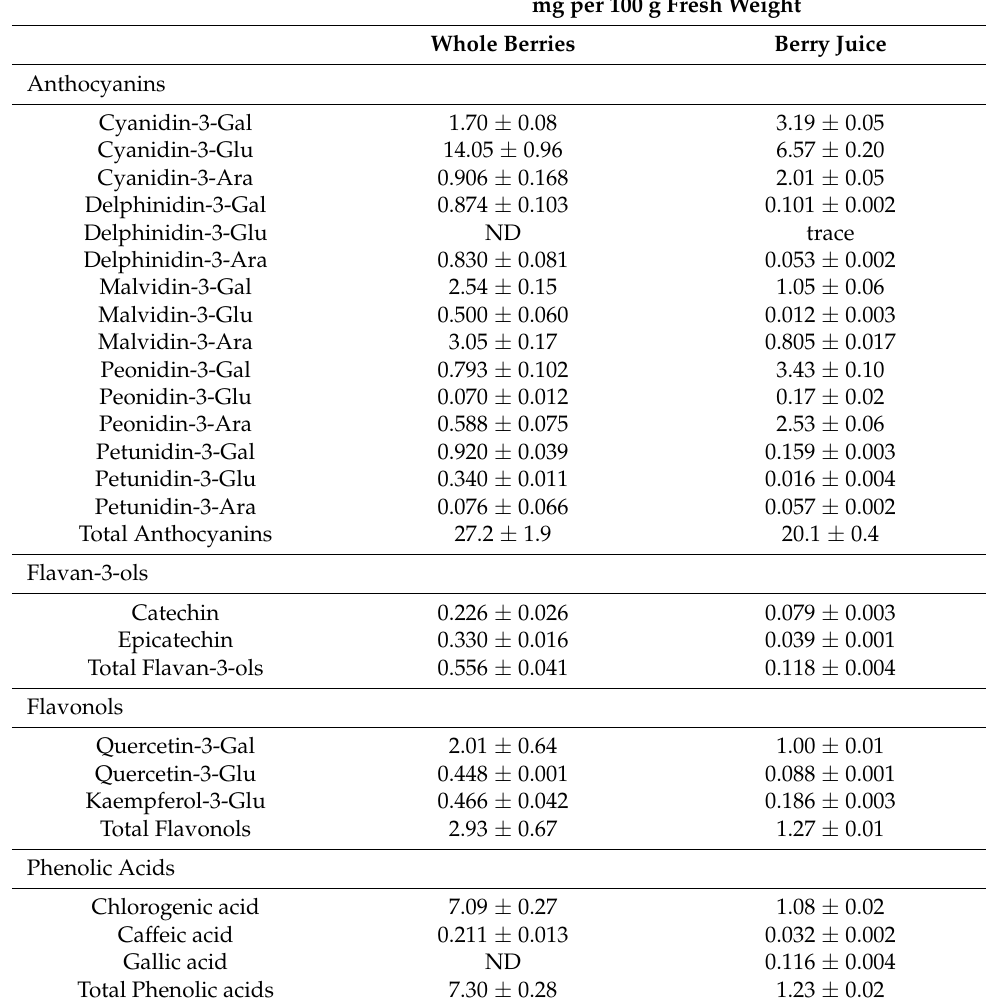
Table 3. Phenolic compounds in berry treatments 1